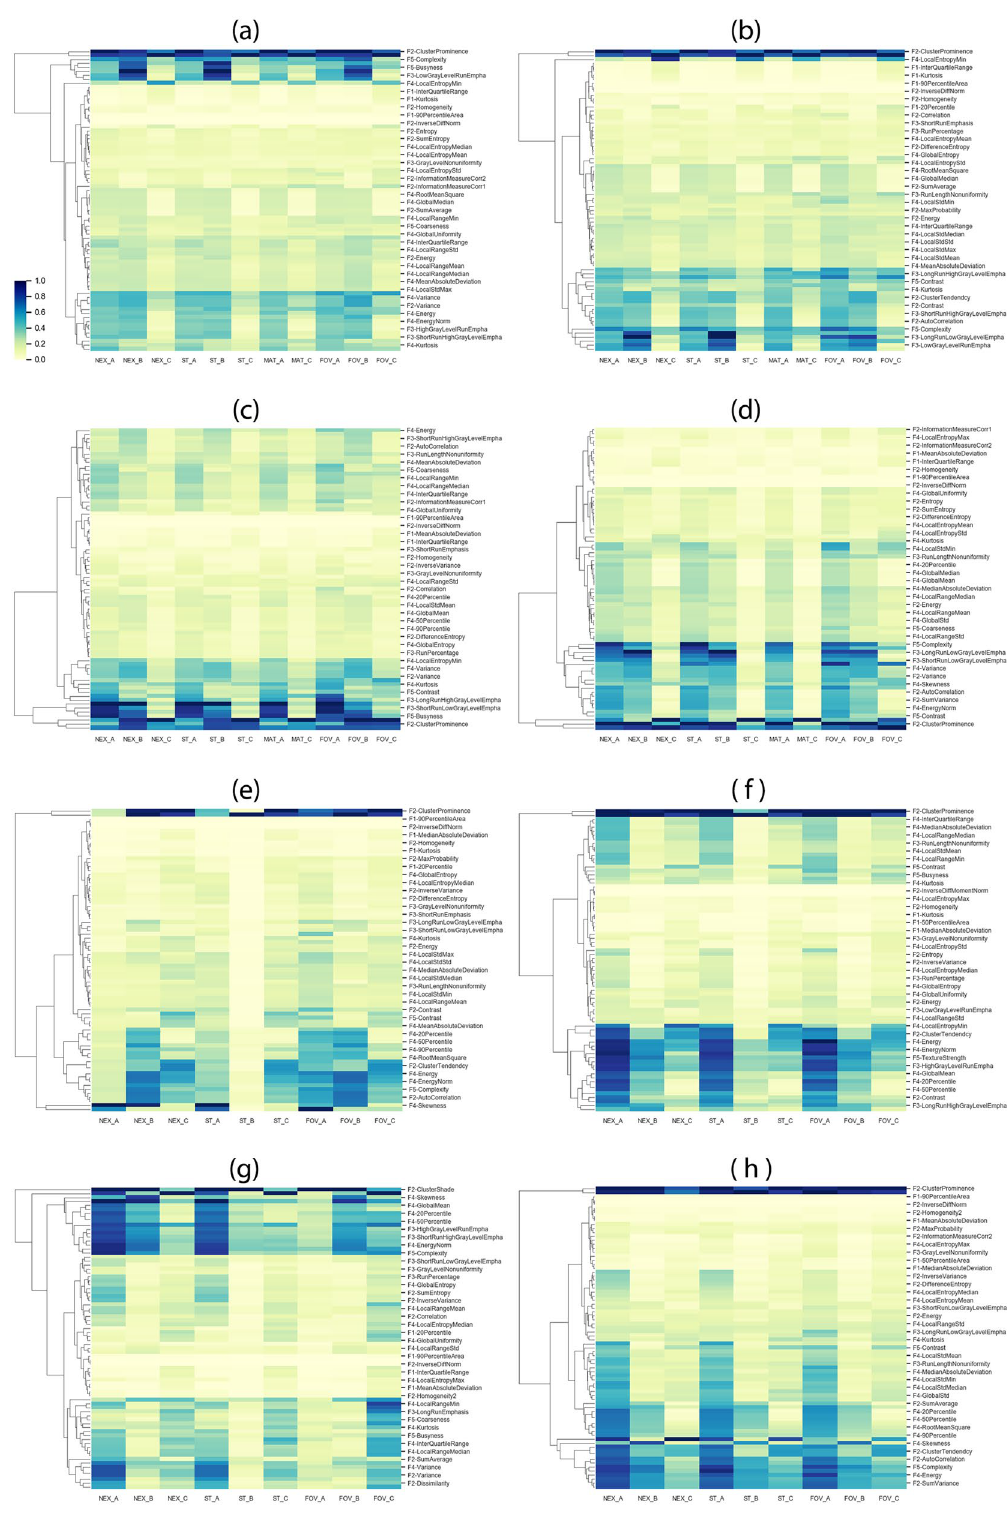
Figure 2. Heat map of the variability of radiomics features with different MRI scanning settings for ( a ) T1-weighted and ( b ) T2-weighted images without normalization and filtering. ( c , d ) shows the heat map for T1- and T2-weighted images with normalization. ( e , f ) shows the heat map for T1- and T2-weighted images with filtering, respectively. We also test the variability of radiomics features with different ROI size (regular ROI = diameter of 1.8 cm and small ROI = diameter of 1.2 cm). ( g , h ) shows the heat map for T1- and T2-weighted images with smaller ROI size. On the x-axis, _A, _B, and _C represent phantom scanned using the Siemens 1.5 T scanner, phantom scanned using the Philips 1.5 T scanner, and volunteer scanned using the Siemens 1.5 T scanner, respectively. The COV value is rescaled from 0 to 1 with blue representing high COV values. The hierarchical clustering on the y-axis was computed using a Euclidean distance measure. The full feature names for each plot listed in the tables S13, S14, S15, and S16 in the supplementary